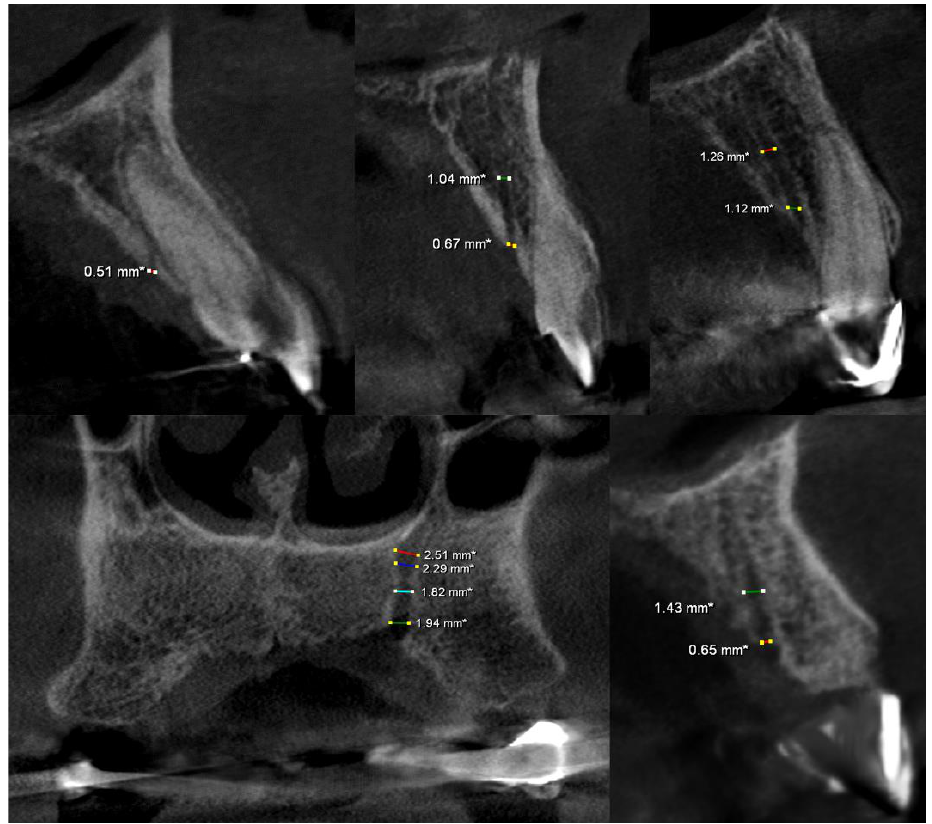
Figure 2. Sagittal and coronal CBCT slices of various exposed ACs cases. Note that the AC curve, extension, and diameter may vary in each case. Red-Blue-Cyan-Green lines demonstrate different diameters at different levels.